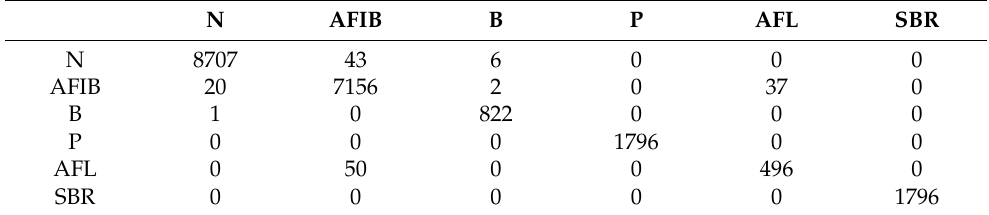
Table 6. Confusion matrix for classification of indistinguishable ECG rhythms.